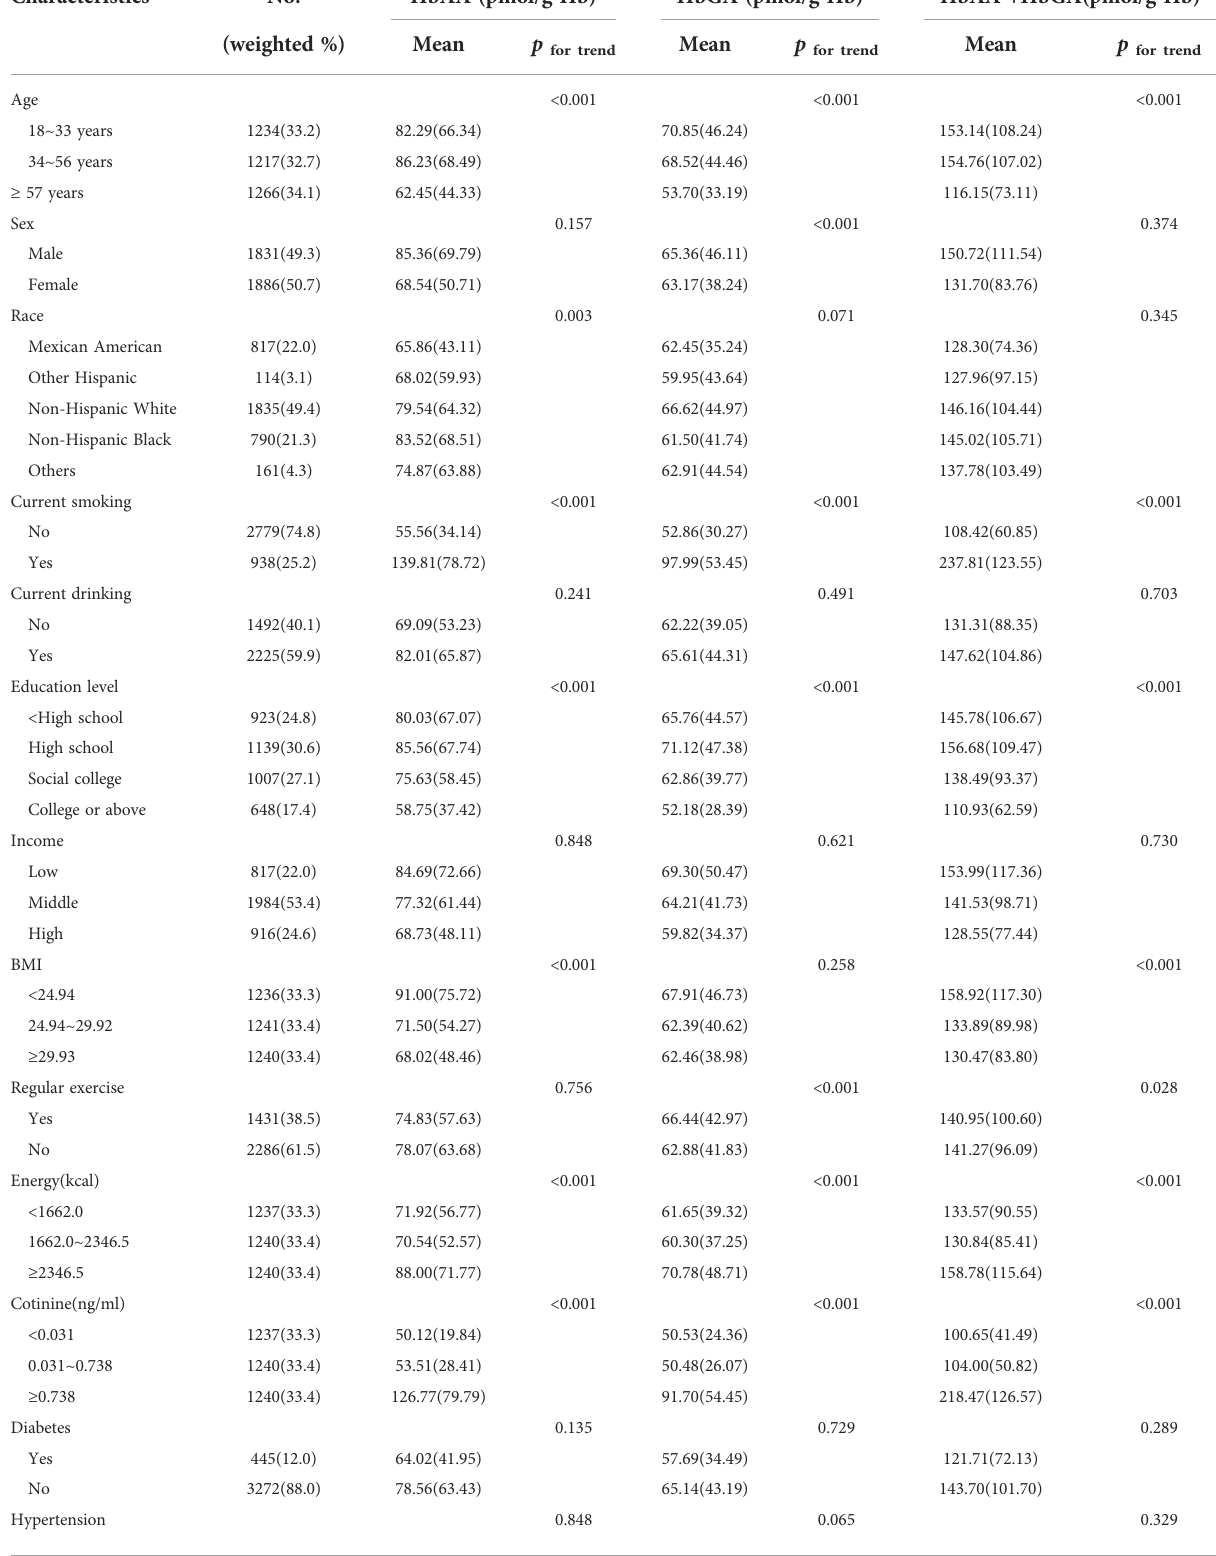
TABLE 1 The levels of hemoglobin biomarkers of AA categorized by participants characteristics.